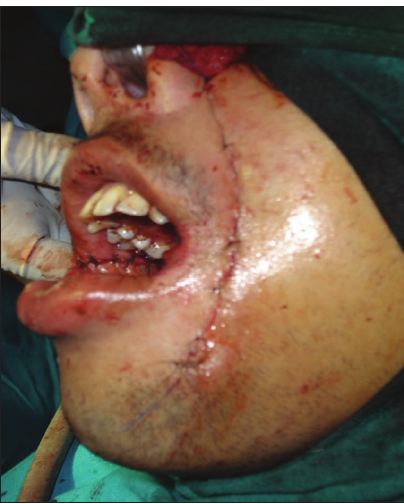
Figure 5: Extra oral suturing.